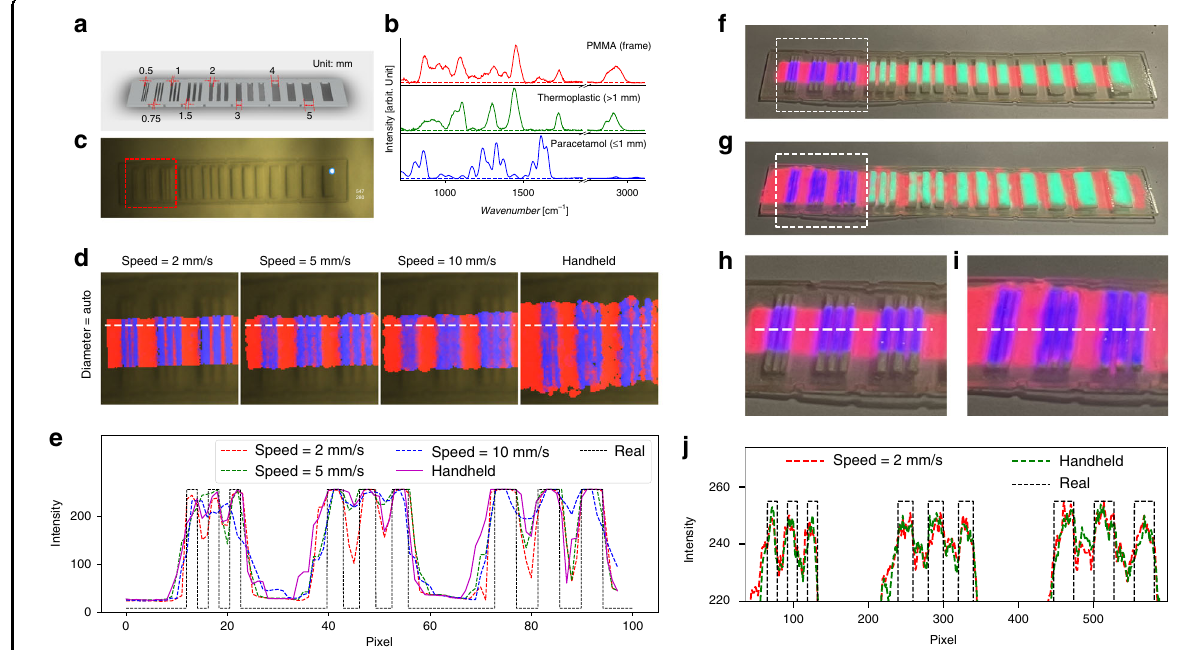
Fig. 6 Evaluation of the spatial resolution of the developed approach. a Diagram of the spatial resolution target with stripes of various widths. The gaps between the stripes are fi lled with moldable thermoplastic (polycaprolactone) and paracetamol powder for gaps >1 mm and ≤ 1 mm, respectively. b Raman spectra of the relevant three components are color-coded, i.e., red for PMMA, green for thermoplastic, and blue for paracetamol. c Bright fi eld image of the spatial resolution target and an indicator of the ellipse fi tted laser spot with positional information. The red dashed box indicates the ROI for imaging cropping. d The cropped augmented Raman images in the ROI of the auto-scale reconstructed diameter of the circles by moving probe at various speeds or handheld operation. The white dashed line on each image indicates the line for pro fi le analysis. e The plots of the blue path (paracetamol plane) of the lines pro fi le from the individual augmented Raman images. The black dashed line indicates the real region of the gaps fi lled with paracetamol. f Photograph of the mixed Raman reality result by projecting the molecular image reconstructed for the speed moving speed of 2 mm/s and the auto-scale diameter condition; and g for handheld operation. The white dashed boxes in the images indicate the ROI shown in detail in h and i and the corresponding intensity pro fi les of the dashed white line are presented in j . The real curve (black) indicates the gaps where the paracetamol is fi lled